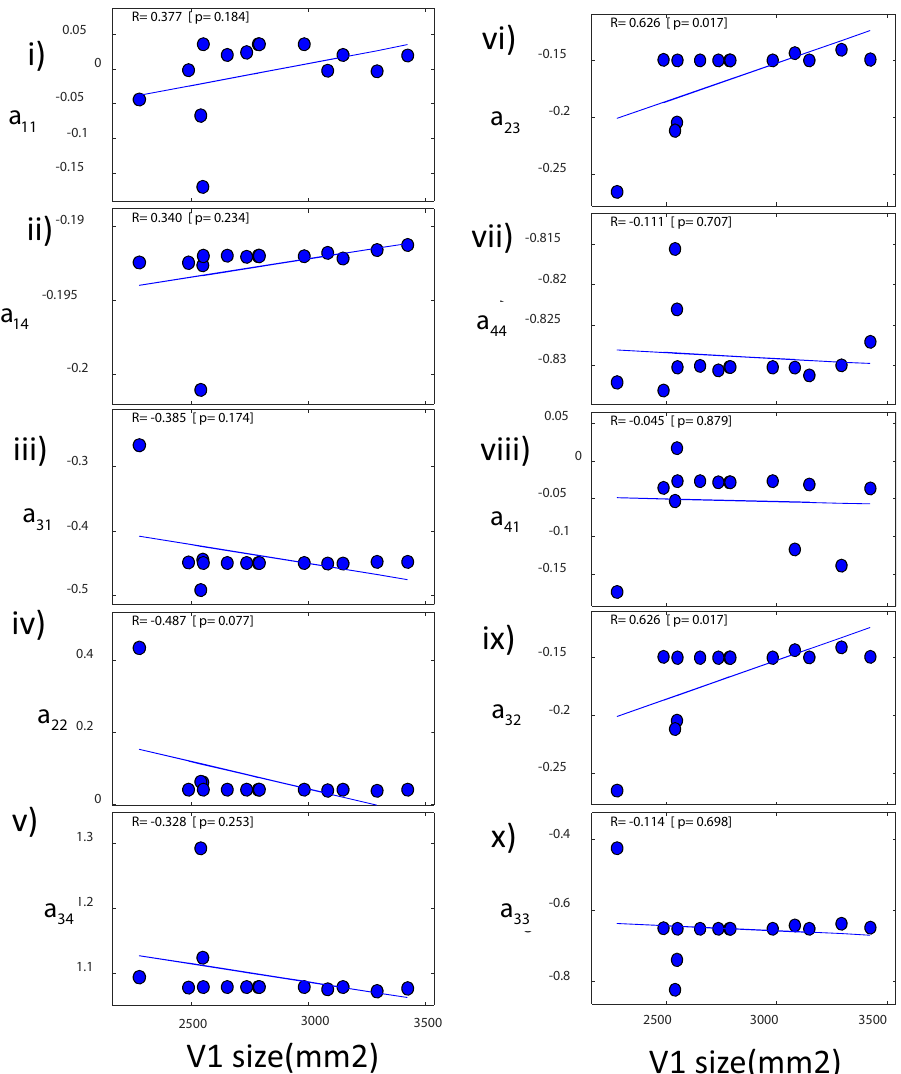
Fig. 5 Connection changes in data from ref. 15 . Correlations between connectivity parameters and V1 size using data from ref. 15 . Changes in the connections between the deep pair of excitatory and inhibitory populations, a 23 and a 32 , signi fi cantly correlated with different V1 sizes (vi and ix). Least- squares fi tted line shown in